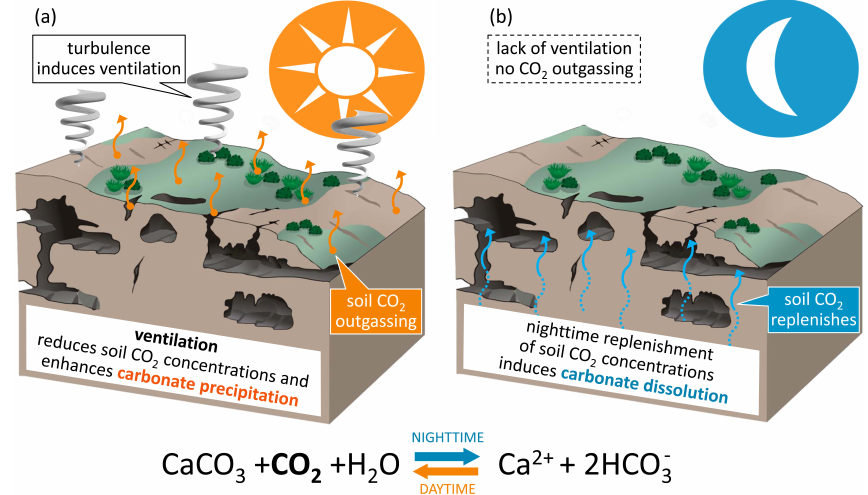
Fig. 4. Overview of the diurnal cycle of carbonate geochemistry with ventilation. Figure 4 shows a conceptual framework that may explain why and how diurnal cycle of carbonate dissolution and precipitation can be exacerbated by ventilation. (a) During the day, gaseous subterranean CO 2 concentrations are kept low by ventilation, which stimulates carbonate precipitation and concurrent geochemical CO 2 production. This CO 2 is then again removed by ventilation, thus sustaining prolonged CO 2 emission events even in the absence of respiratory CO 2 production. The stronger the ventilation, the more carbonate precipitates. (b) At night, ventilation ceases and diffusion of CO 2 from the soil to the atmosphere is reduced by: first, nocturnal rewetting of the upper soil layer that reduces open porosity and, second, the small CO 2 concentration difference between soil and atmosphere resulting from a day with ventilation. CO 2 from deeper layers migrates upwards to the depleted upper layers, where it stimulates carbonate dissolution and thus CO 2